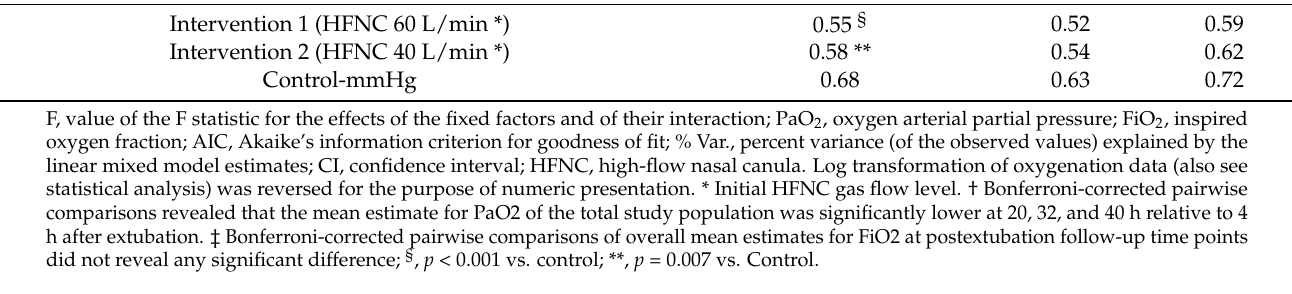
Table 4. Results of mixed-model analysis for the VAS comfort scale score and of the pairwise comparisons for the frequency of use of accessory respiratory muscles at the follow-up time